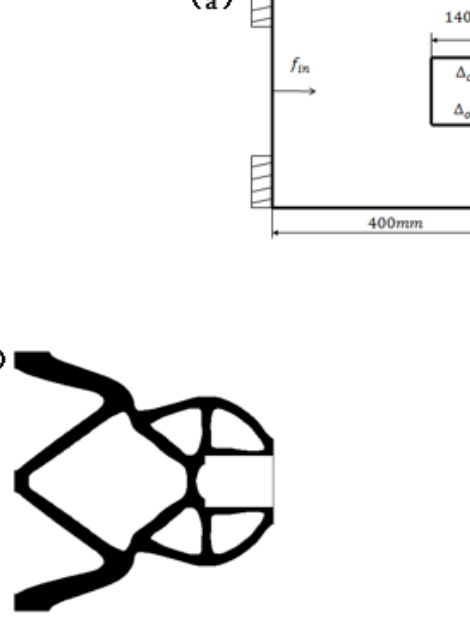
Figure 2. ( a ) Design domain and boundary of the gripper mechanism; ( b ) optimized topology solutions obtained by minimizing synthesis weighting index (SWI) with weighting coefficient 10 of the 1st eigen-frequency; ( c ) optimized topology solutions obtained by minimizing synthesis weighting index (SWI) with weighting coefficient 100 of the 1st eigen-frequency.